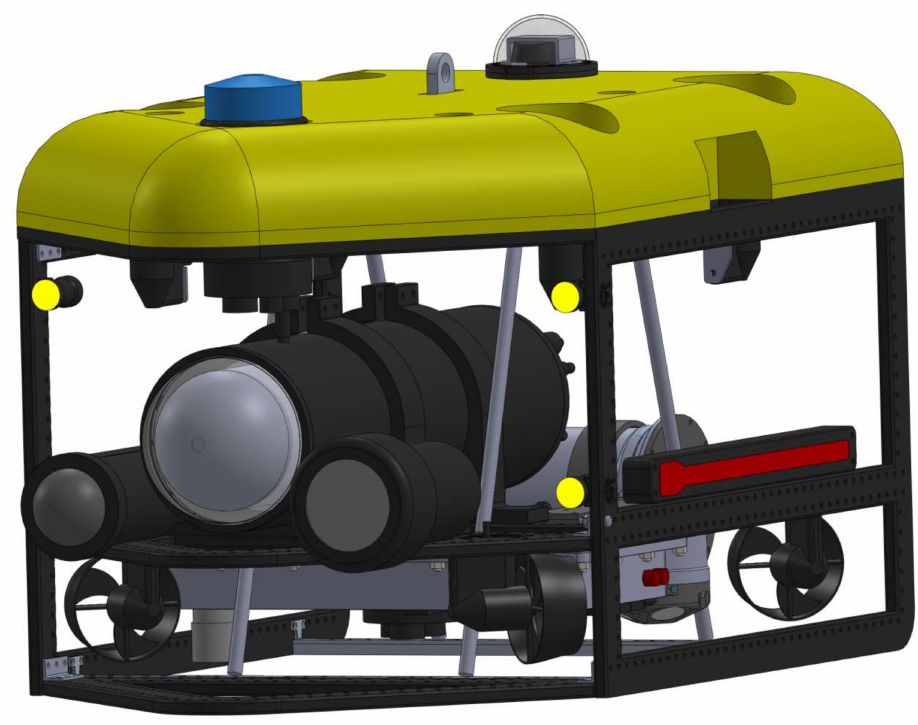
Figure 1. Inspection-class remotely operated vehicle (I-ROV), developed at the Centre for Robotics & Intelligent Systems (CRIS) researchers, University of Limerick